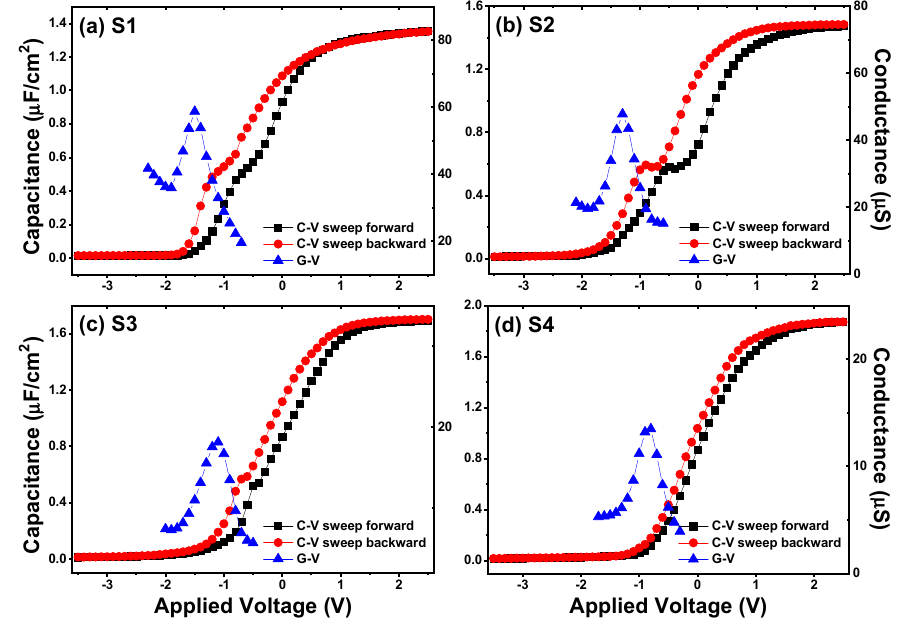
Figure 6. C-V curves and G-V characteristics of the fabricated Al / HfO 2 / La 2 O 3 / Ge MIS capacitors with different ALD cycles of La 2 O 3 passivation layer. ( a ) The control sample; ( b ) 5 ALD cycles of La 2 O 3 passivation layer; ( c ) 10 ALD cycles of La 2 O 3 passivation layer; and ( d ) 15 ALD cycles of La 2 O 3 passivation layer. The curves were measured at the frequency of 100 kHz.